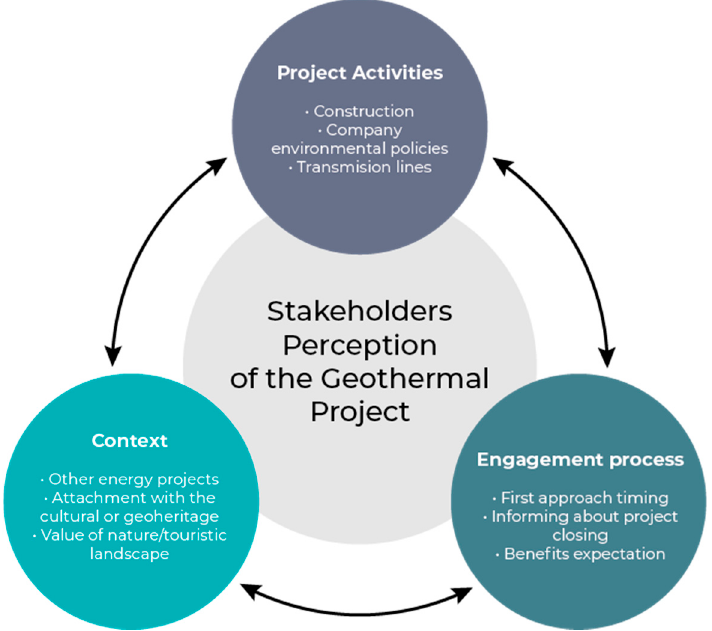
Figure 6. Influence diagram of the perception factors. The factors of each of the three categories and the combination of them influenced stakeholders’ perception (modified after Vargas-Payera et al. [83].